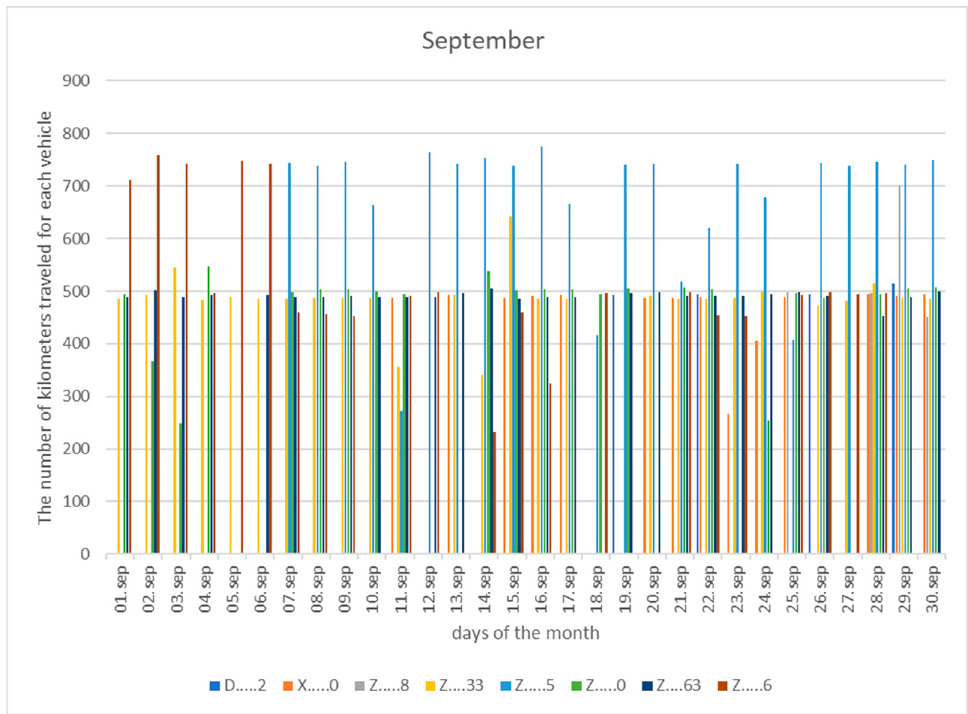
Figure 5. The number of kilometres travelled for each vehicle in September.